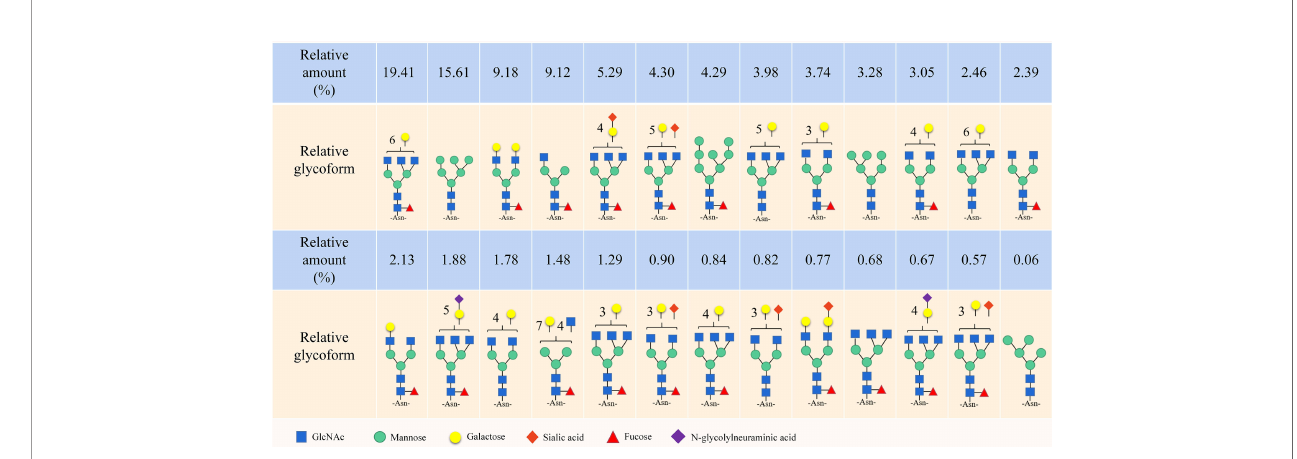
FIGURE 2 | N-Glycans mudel presented on